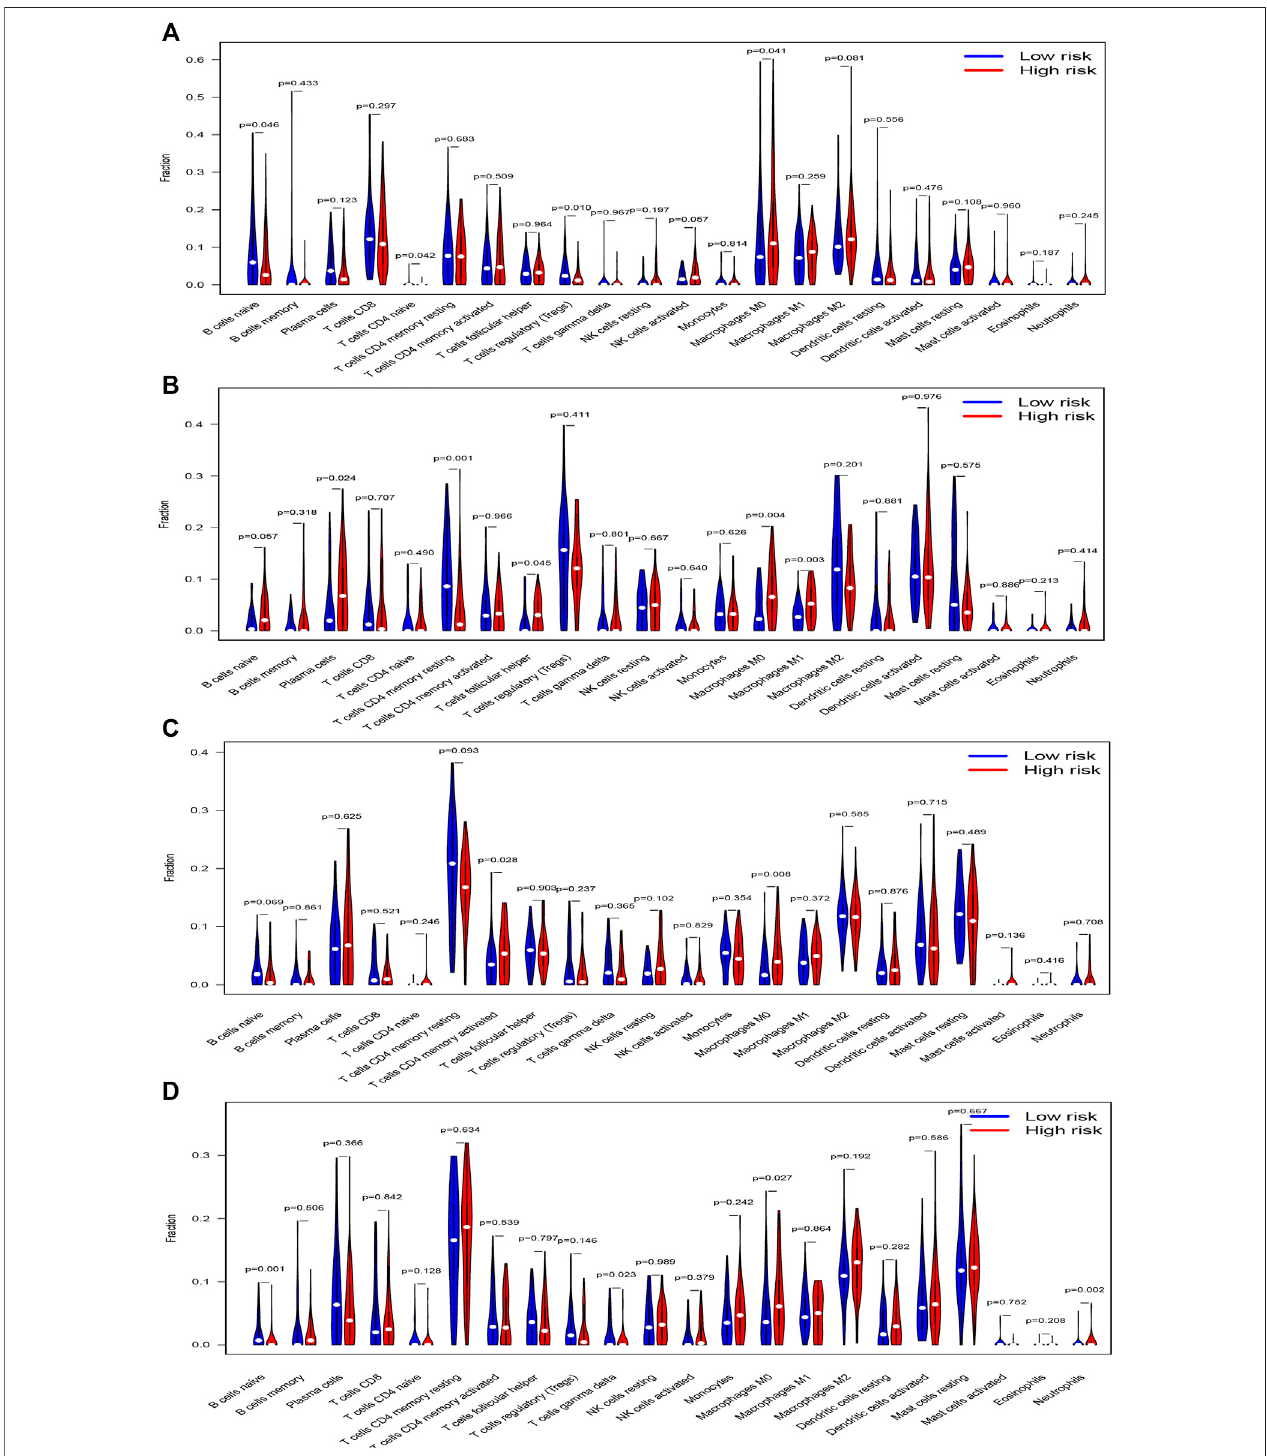
FIGURE9| Thevioplots of22immune cellscontentsofthehigh-risk and low-riskgroup in (A) TCGAdataset, (B) GSE13507, (C) GSE32548, and (D) GSE48075. M0 macrophages were all signi fi cantly different in these four datasets and M0 macrophages had higher in fi ltration in the high-risk group.